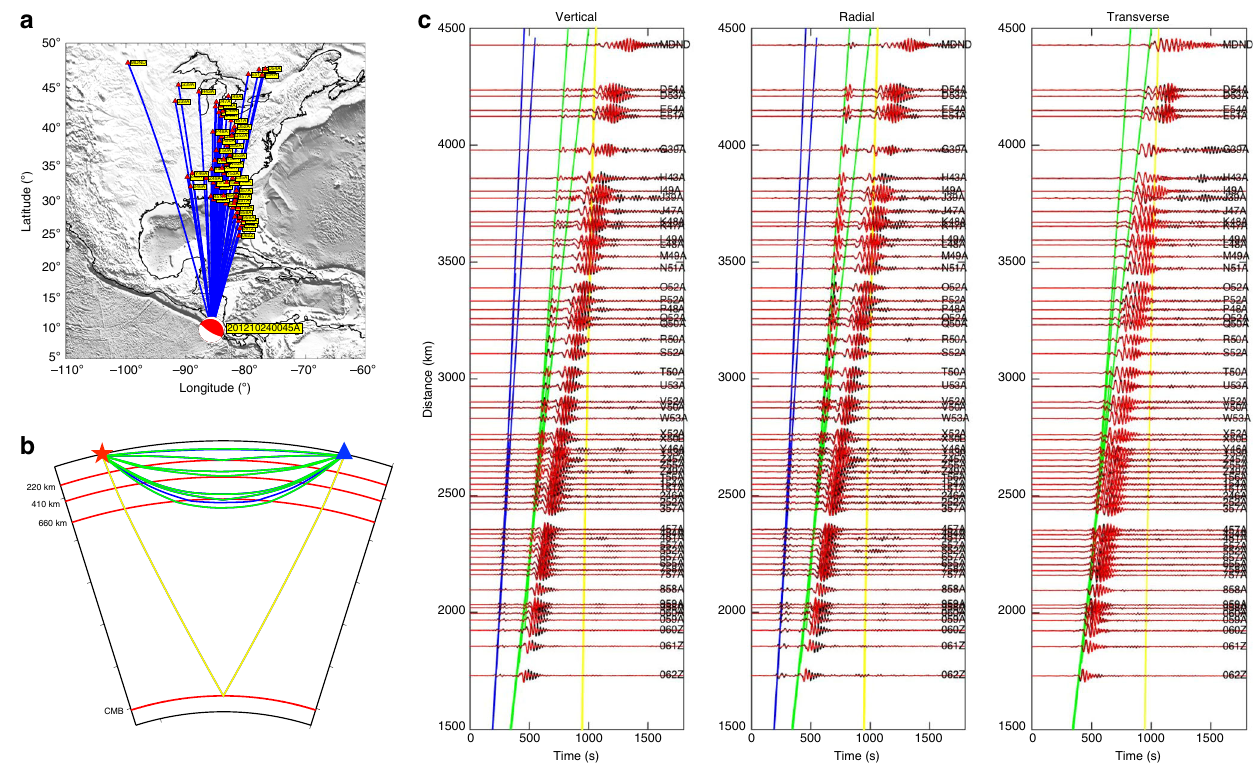
Fig. 2 Comparisons of observed and predicted seismograms from model US 32 . a The locations of 1 earthquake and 58 stations from the USArray deployed in the eastern U.S. This Mw 6.0 earthquake occurred at a depth of 18.3 km underneath Costa Rica on October 24th, 2012 (CMTSOLUTION_201210240045A). b The theoretical ray paths of P (blue), S (green), ScS (yellow) phases in the spherical symmetric PREM model 88 , with the epicentral distance equal to 25°. Red lines denote the 220, 410, 660-km discontinuities and the core mantle boundary. c Compares three- component, observed (black) and predicted (red) seismograms for TA stations shown in a . From left to right are vertical, radial and transverse components, respectively. Blue, green and yellow lines denote the theoretical arrival times for P, S and ScS phases from the PREM model. Both observed and predicted seismograms are bandpass fi ltered from 25 to 100 s.